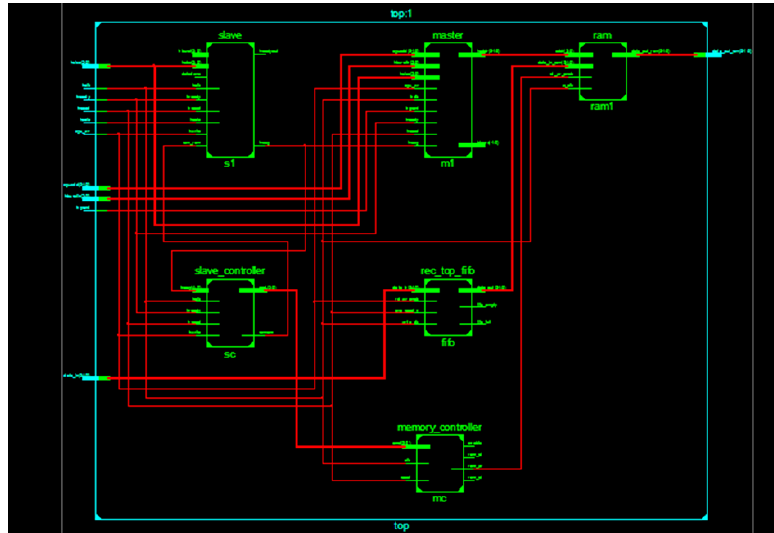
Fig. 10. Simulation waveform of slave interface